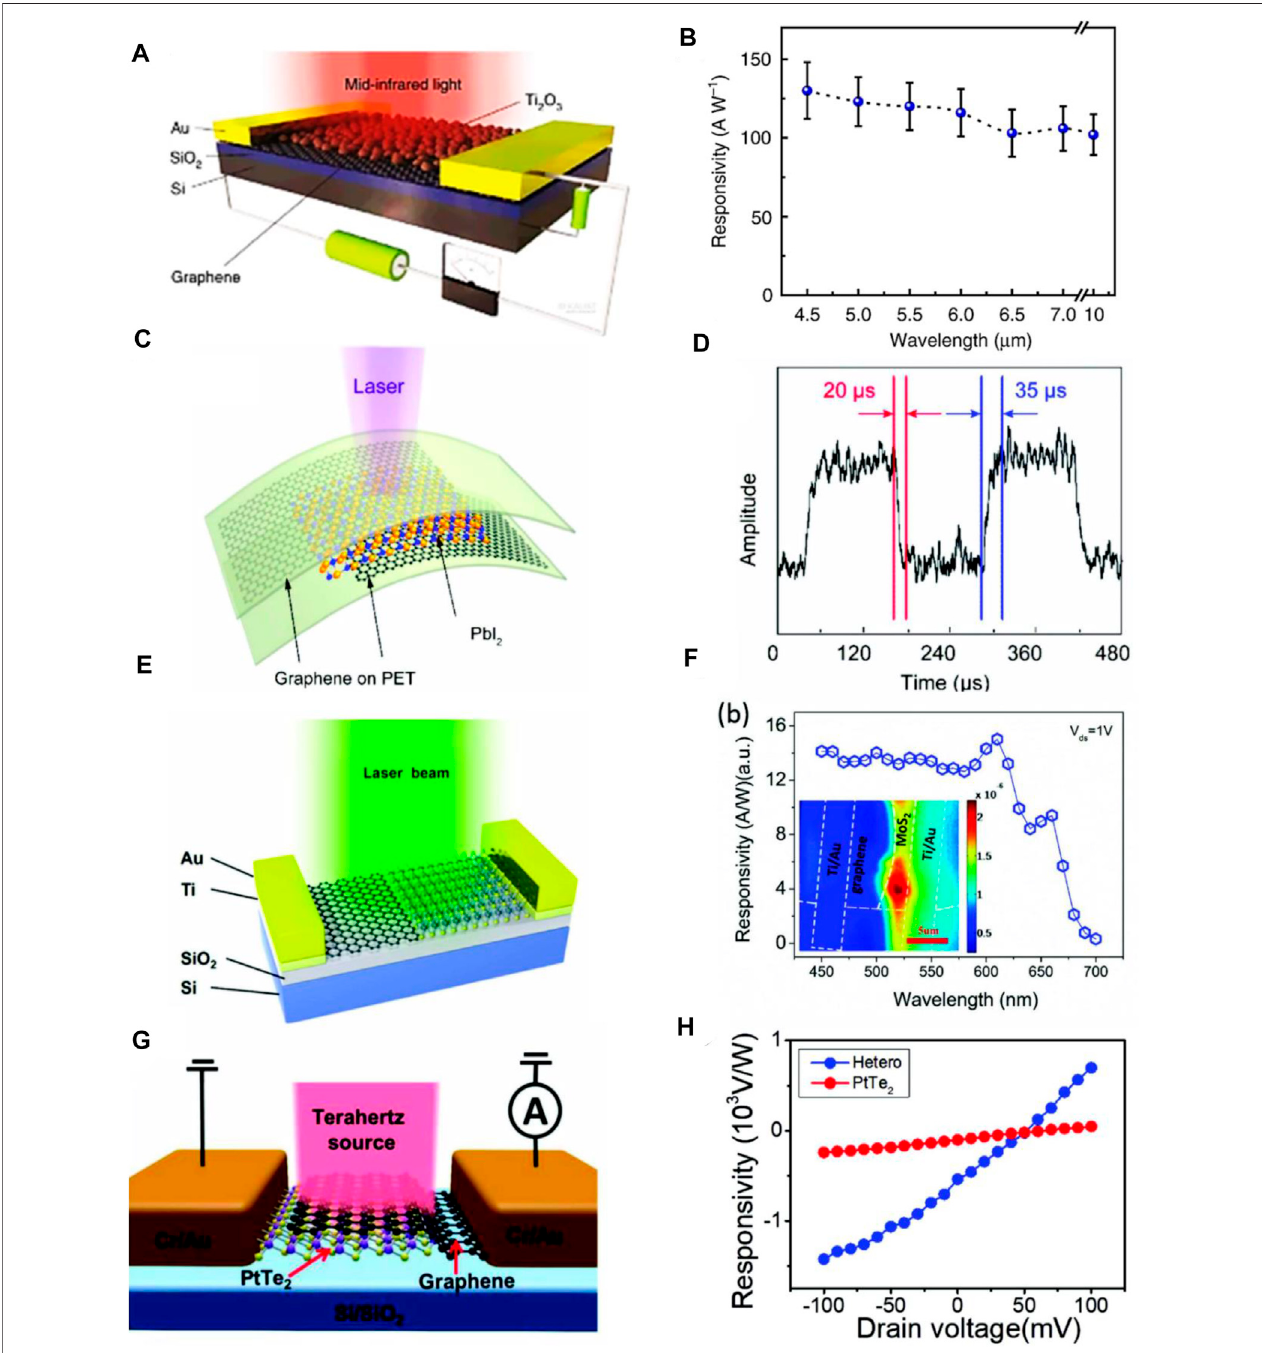
FIGURE 12 | 2D heterostructure photodetectors (A , B) Schematic and responsivity spectra of hybrid graphene/Ti 2 O 3 photodetector (Yu et al., 2018a), (C , D) PbI 2 based photodetector and its photo-response spectra (Zhang et al., 2018), (E , F) Graphene-MoS 2 photodetector and its photoresponsivity (Deng et al., 2018b), (G , H) Schematic of PtTe 2 based photodetector and its responsivity spectra (Xu et al., 2019); Reproduced with permission from (Yu et al., 2018a; Deng et al., 2018b; Zhang et al., 2018; Xu et al., 2019).